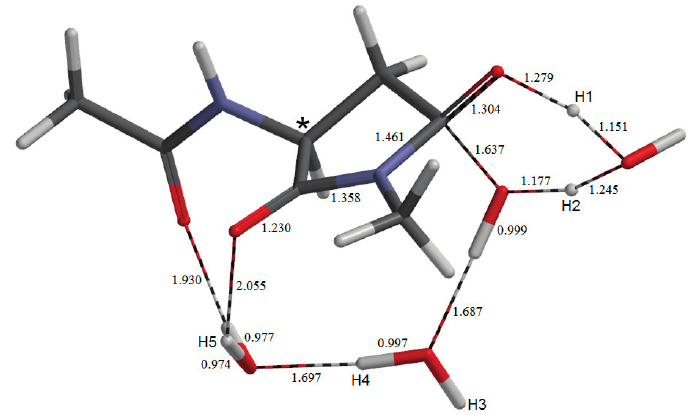
Figure 11. The geometry of the sixth-step transition state TS6 . Selected interatomic distances are shown in Å.